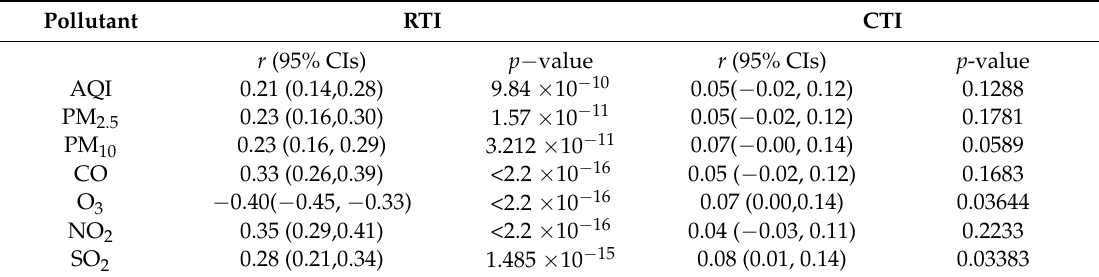
Table 4. The results of the Pearson correlation analysis (RTI: respiratory total index, CTI: cardio- and cerebrovascular total index).